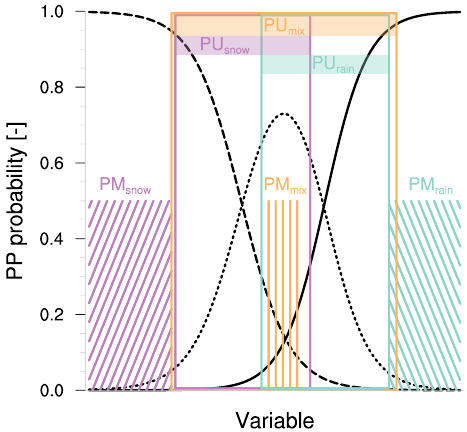
Figure 8. Graph illustrates the calculation of PU (framed) and PM (hatched) including snow (dashed/purple), mixed phase (dot- ted/orange), and rain (solid/cyan), analogous to Fig. 3 in Froidurot et al. (2014). PU divides the sum of cases with 0 . 05 < p (PP) < 0 . 95 for all PPs by the sum of all RSM cases. PM divides the sum of cases with p (PP) > 0 . 95 for one of the PPs that disagrees with the manual PP estimation by the sum of all RSM cases. We set PM mix > 0 be- cause otherwise we could not display it in the same PP distribution (rH kept constant) with PU > 0.